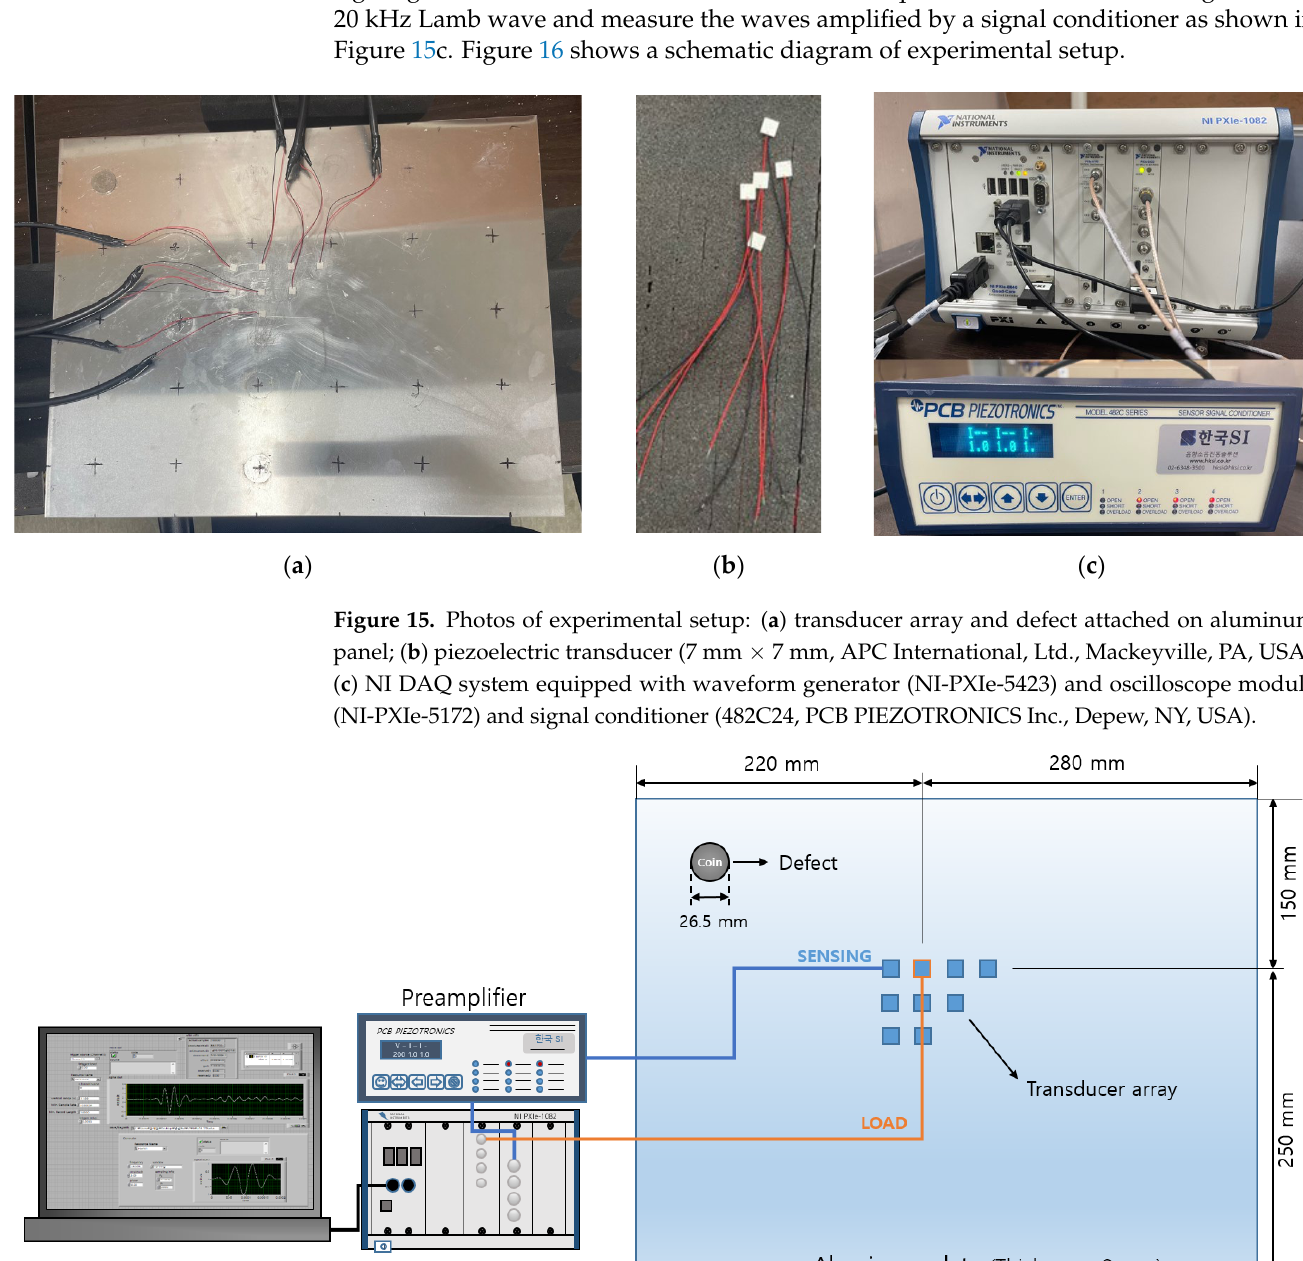
( b ) Figure 17. ( a ) Multiple defect locations to train for one standard position; ( b ) excitation signal for each frequency. On the other hand, it is analyzed that the reflected wave from a defect is measured approximately from 0.06 ms to 0.52 ms after reaching the maximum value of the direct wave. In order to extract the features, the corresponding time data of the defect - induced reflected wave at each sensor are converted into a color band. Then, a 2D image is created by stacking the color bands upward as shown in Figure 18. In this way, 51 data sets are obtained for each defect, and all of them are labeled as the reference defect located at the corresponding standard position. Among them, the image obtained from the defect in the middle position, excited at 20 kHz, is used as a verification image, and CNN training is conducted with the remaining 50 images. MATALB is used for the image creation and CNN training and validation.